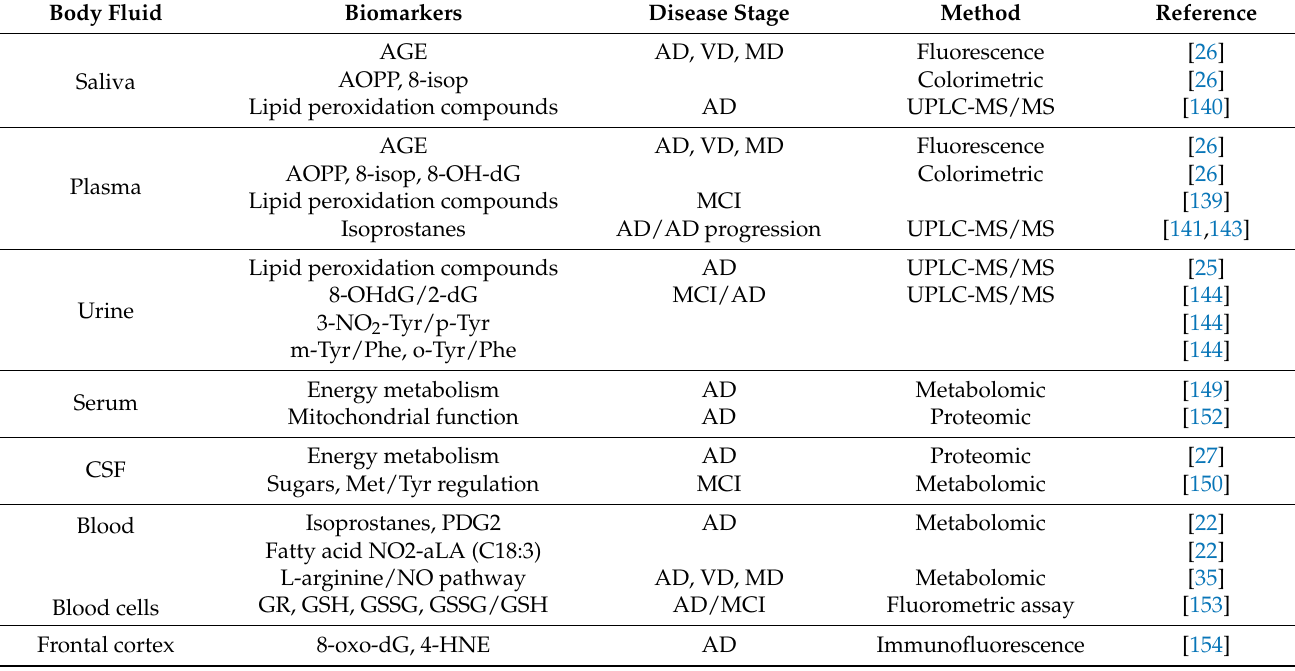
Table 1. Summary of recent studies on OS-related biomarkers for diagnosis and progression evaluation in AD. Body